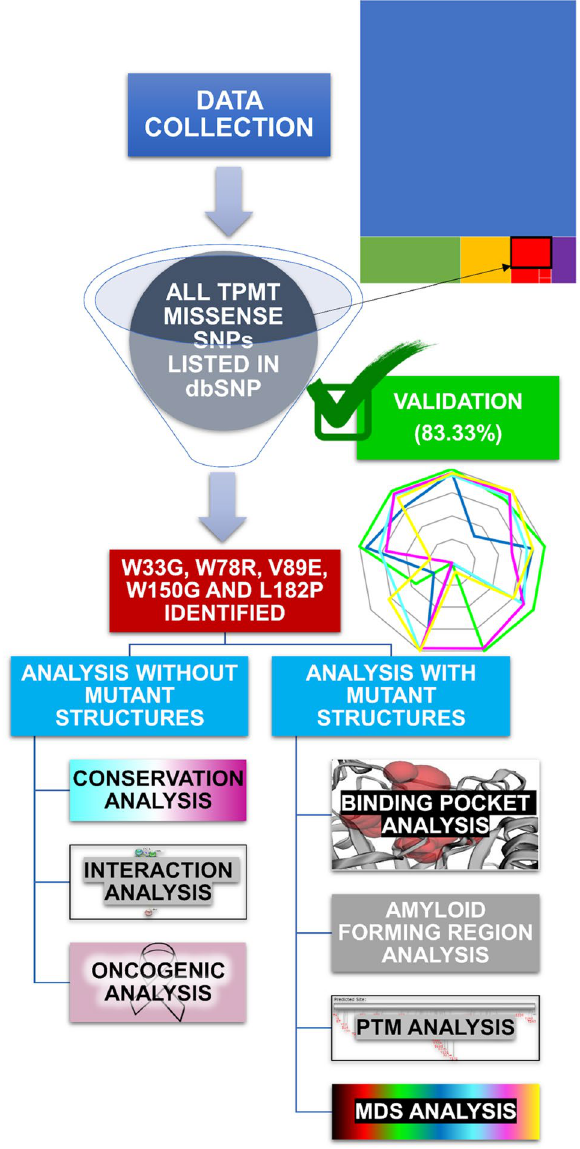
Figure 1. Visual representation of the methodology followed in the present study (The rectangle on the top right represents the pool of all TPMT SNPs. Please refer to Figure S1 for more